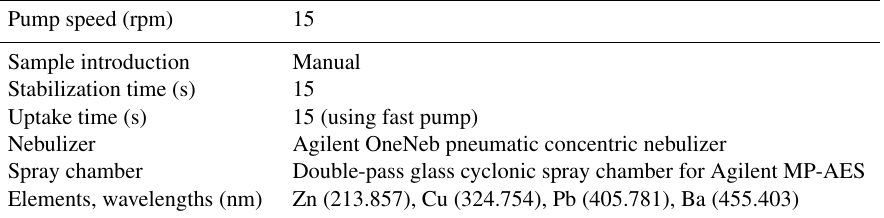
Table 2. MP-AES configuration and operating conditions.